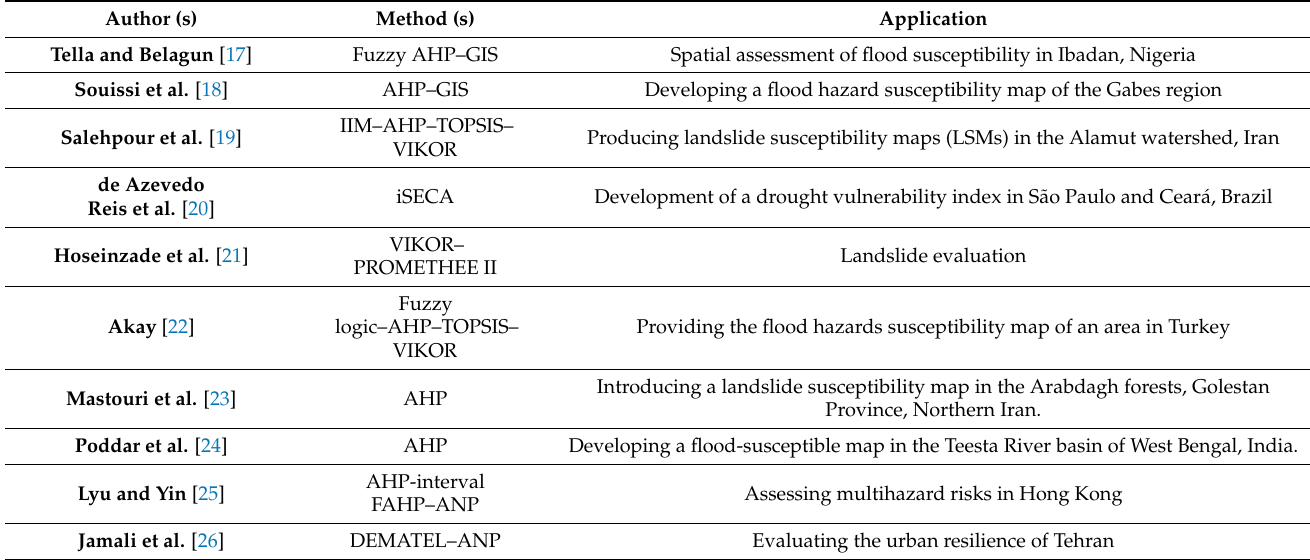
Table 1. Literature review on natural hazards and the application of MCDM